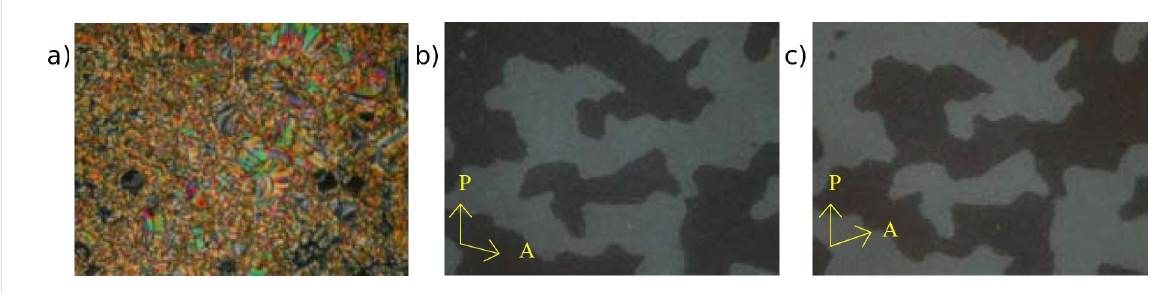
texture were observed by polarising optical microscopy (Figure 1a), which is a hint for a layer structure. In contrast, the mesophases of the halogen-substituted compounds OH 1b and OH 1c appeared optically isotropic with crossed polarisers. By rotation of one of the polarisers clockwise from the crossed (90°) position, bright and dark domains became visible (Figure 1b). Rotating the polariser anticlockwise by the same angle made the dark domains bright, and vice versa (Figure 1c).